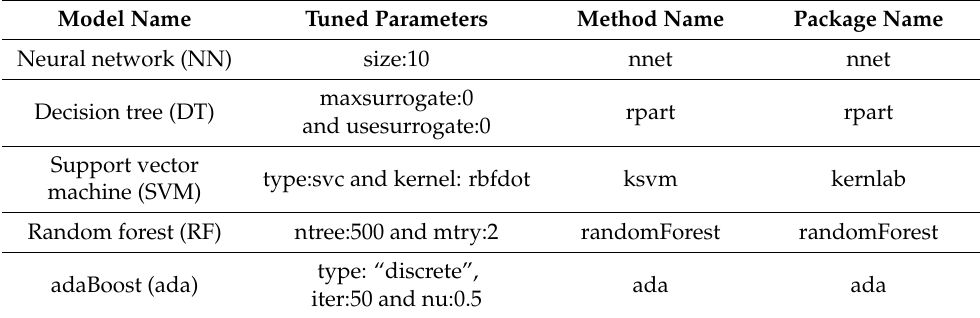
Table 5. Classifiers used for